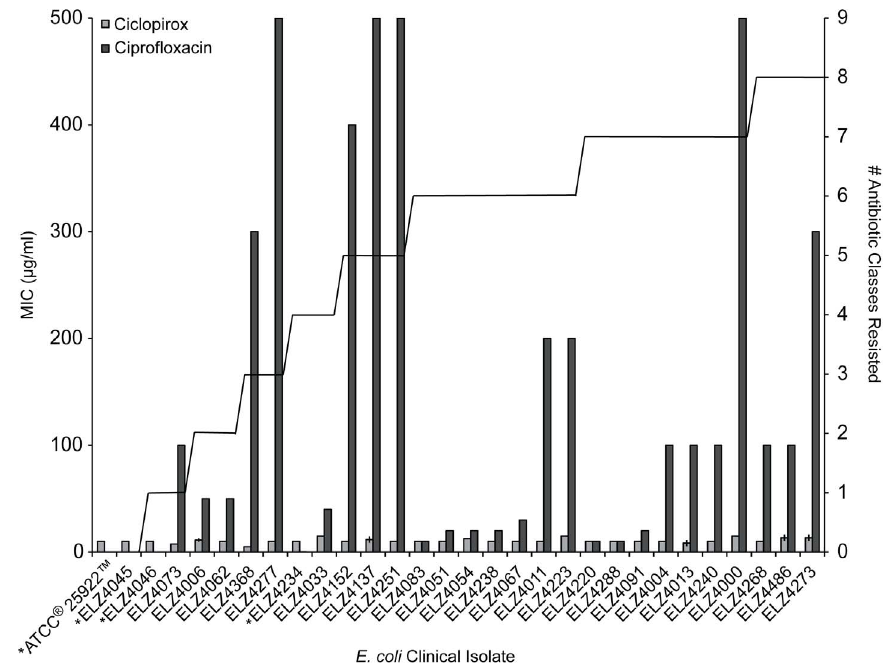
Figure 1. Ciclopirox and ciprofloxacin MICs for E.coli clinical isolates. The left y -axis is the average MIC in m g/ml for ciclopirox (light gray bar) and ciprofloxacin (dark gray bar). The clinical resistance breakpoint for ciprofloxacin is 4 m g/ml and an asterisk indicates isolates with MICs below this breakpoint. MIC measurements were repeated three times, and the average value and standard deviation is shown. The right y -axis denotes the number of antibiotic classes (aminoglycosides, carbapenems, cephalosporins, fluoroquinolones, monobactams, nitrofurans, penicillins, combination penicillins, and sulfamethozazole-trimethoprim) each isolate is resistant to, as indicated by the solid line.